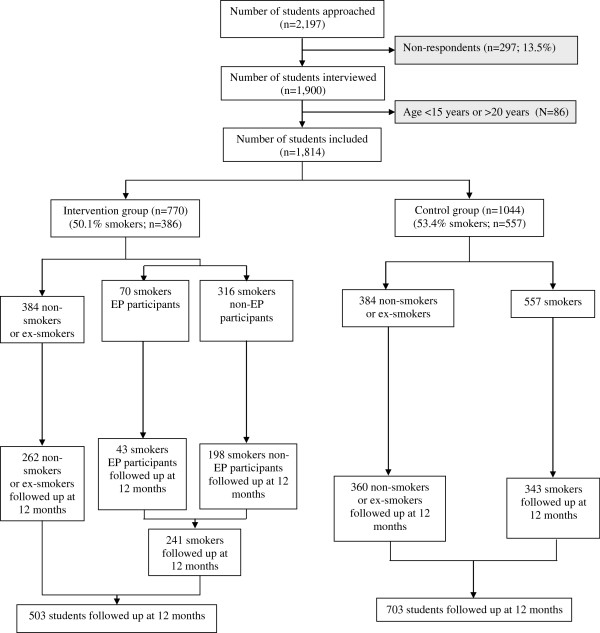
Flow chart illustrating the inclusion and follow-up of students in the TABADO study. TABADO study, Nancy, France, 2008-2009.